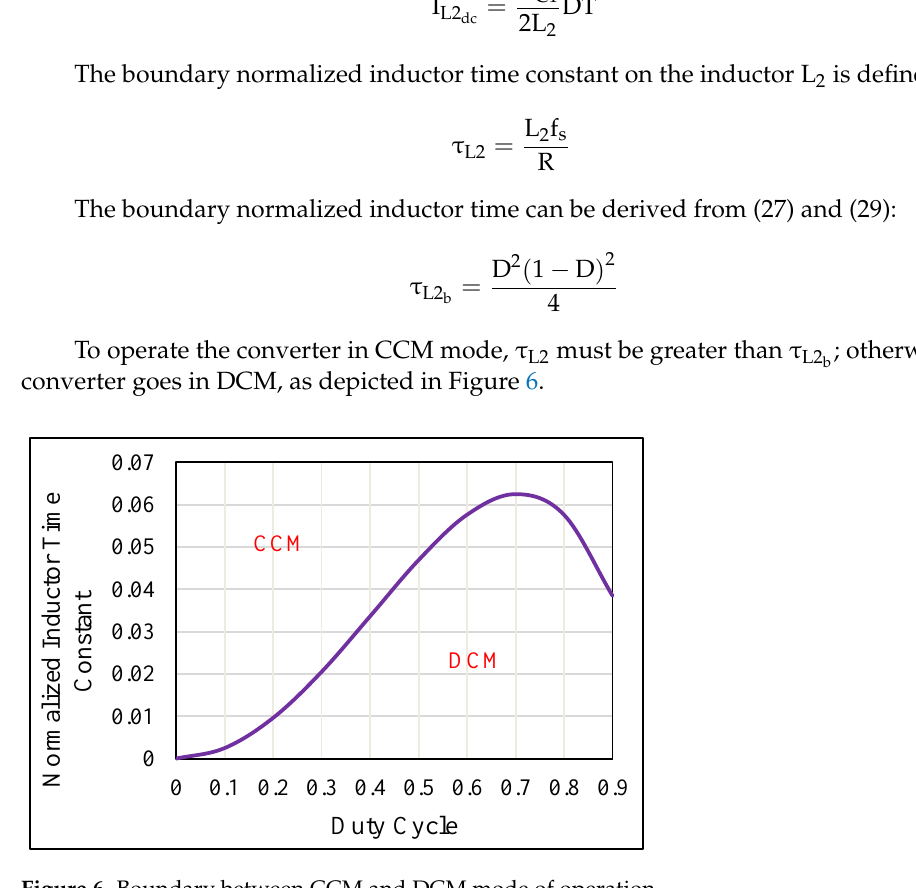
Figure 6. Boundary between CCM and DCM mode of operation.